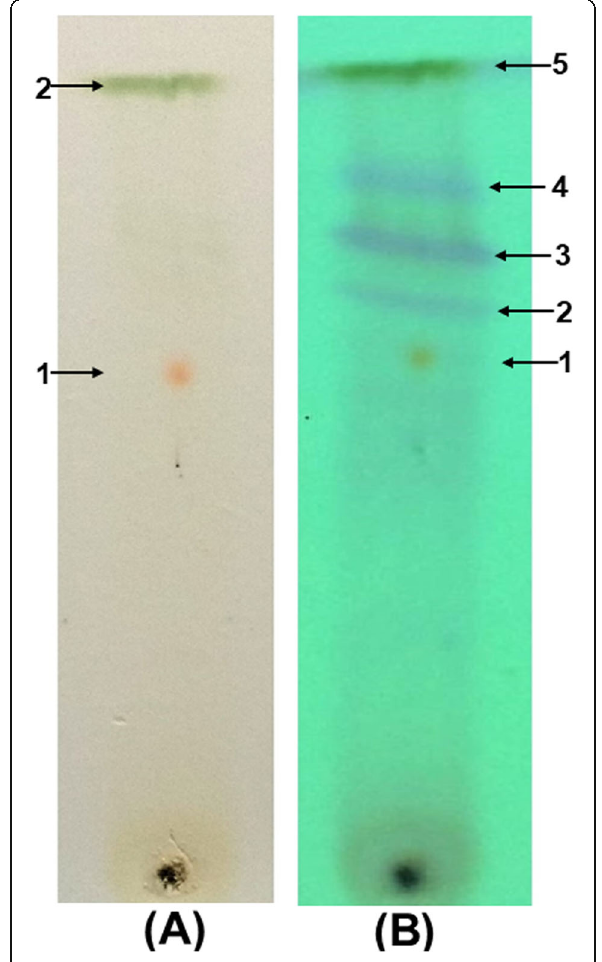
Fig. 1 Thin Layer Chromatograph of methanolic extracts of Andrographis paniculata whole plant: A Visualization in visible regions. B Visualization in UV-regions (254